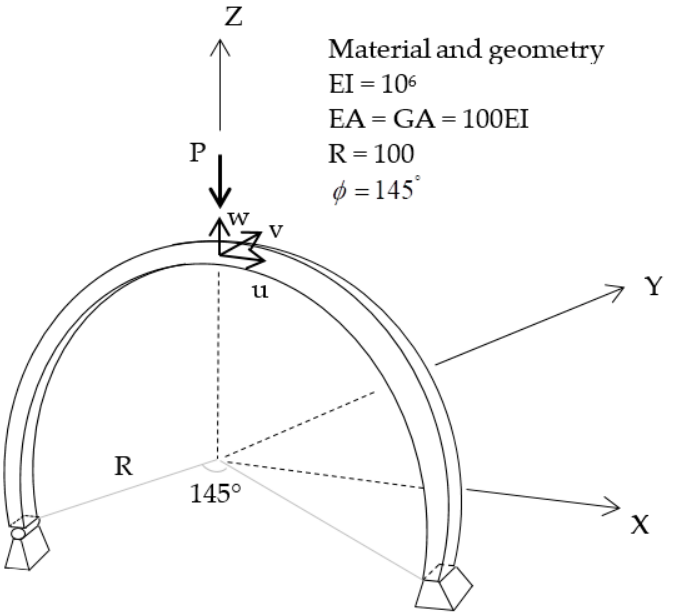
Figure 13. Clamped–hinged circular arch subject to a concentrated load.